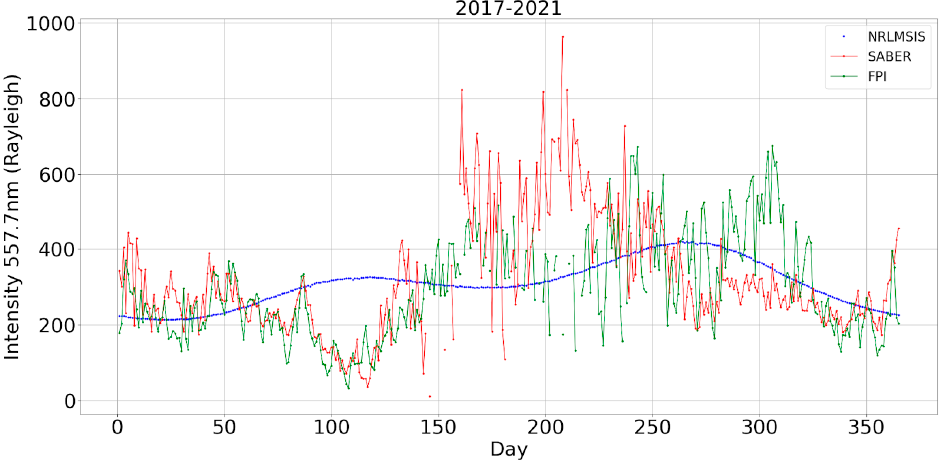
Figure 6. Annual average intensity from 2017 to 2021 from SABER (red), FPI (green) and NRLMSIS model (blue) data.